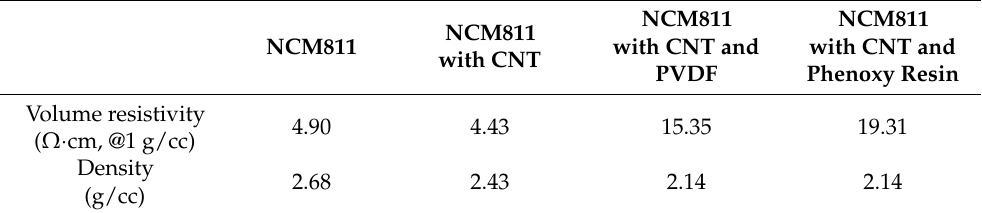
Figure 3. Volume resistivity ( Ω .cm) of (NCM811, NCM811 (w/CNT), NCM811 (w/CNT, PVDF), Figure 3. Volume resistivity (Ω.cm) of ( NCM811, NCM811 (w/CNT), NCM811 (w/CNT, PVDF), NCM811 (w/CNT, phenoxy resin). NCM811 (w/CNT, phenoxy resin). Table 1. Volume resistivity (Ω.cm) of NCM811, NCM811 with CNT, NCM811 with CNT and PVDF, Table 1. Volume resistivity ( Ω .cm) of NCM811, NCM811 with CNT, NCM811 with CNT and PVDF, and NCM811 with CNT and phenoxy resin at each density (g/cc). and NCM811 with CNT and phenoxy resin at each density